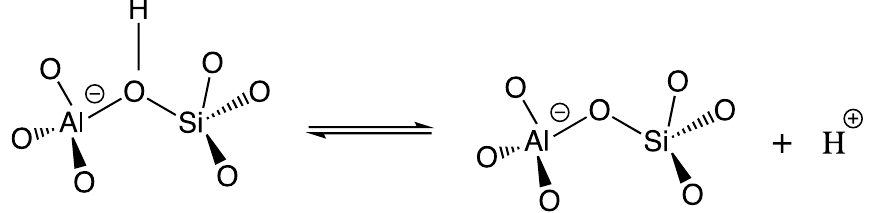
Figure 1. The Brønsted acidity of zeolites stems from the bridging hydroxyl